Question: What style of plot is this figure drawn as?
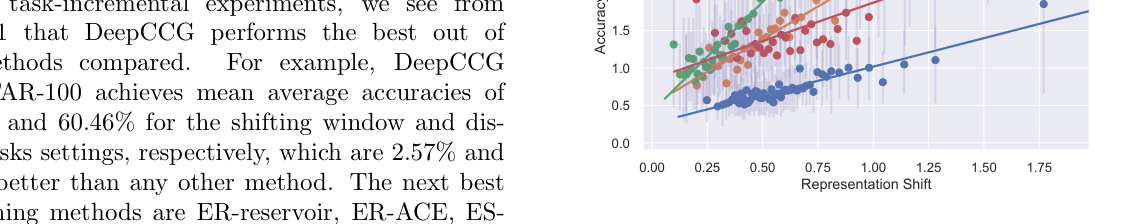
Answer: scatter